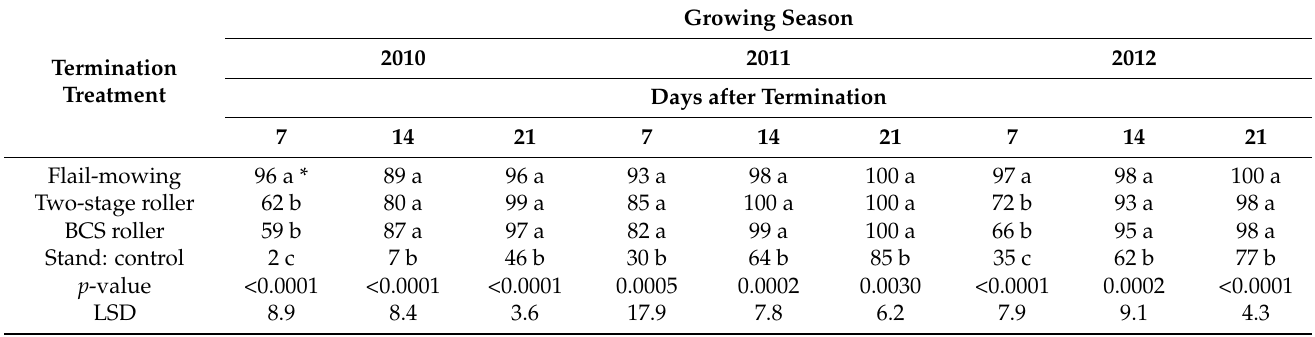
Table 7. Termination rates (%) for cereal rye during three weeks of evaluation in three growing seasons